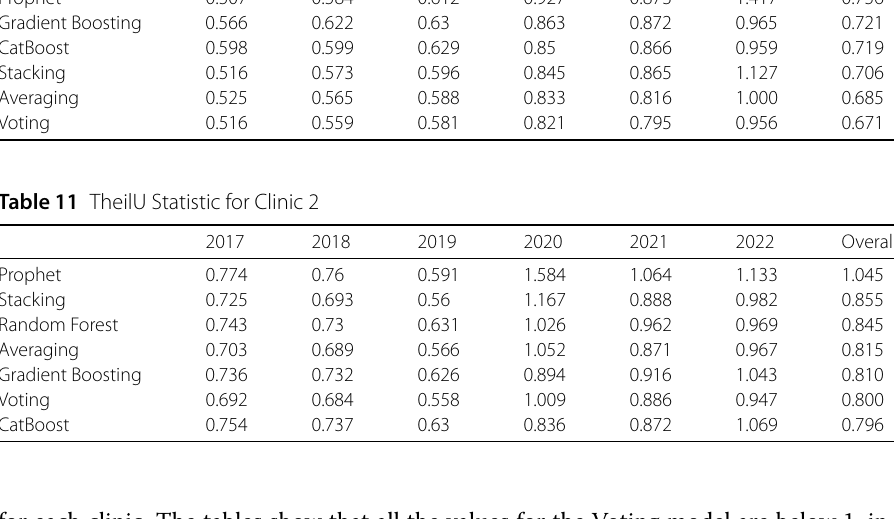
Table 10 TheilU Statistic for Clinic 1 Random Forest